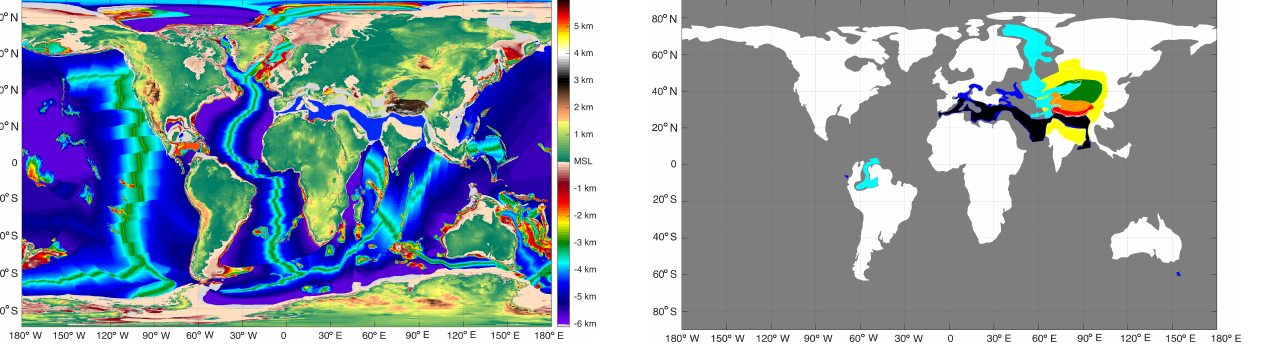
Figure 4. Masks used for manipulation of the reconstruction; white represents land, cyan shallow water, blue sea and black ocean. In southern Asia, green, yellow, orange and red indicate areas that are lowered manually by different